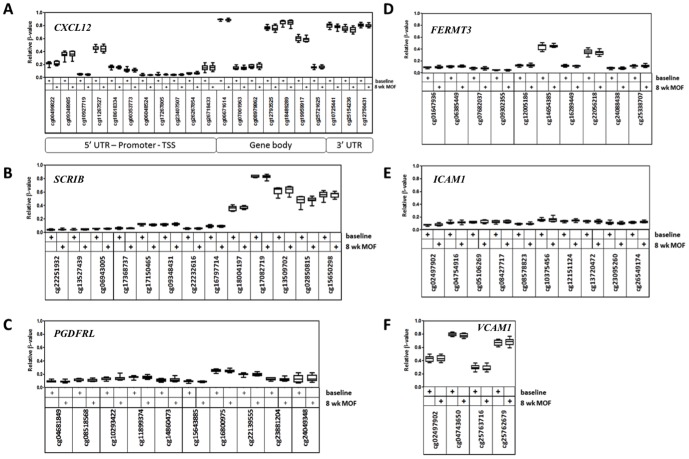
Gene-specific variation in DNA methylation before and after MOF supplementation.Box- and whisker plots represent DNA methylation as β-values (0<x<1, reflecting 0–100% DNA methylation) of 10 individuals before and after 8 weeks MOF supplementation for the following genes: CXCL12 (A), SCRIB (B), PDGFRL (C), FERMT3 (D), ICAM1 (E) and VCAM1 (F). In figure 8A CpG sites have been sorted according to their chromosome locus, including 5′-UTR, promoter (transcription start site region (TSS)), gene body and 3′-UTR region, as indicated in the figure. For figures 8B - F, only the 5′-UTR promoter region (TSS) has been included. No significant MOF effects on DNA methylation β-values could be observed by one-way ANOVA and Bonferroni's post-hoc test.